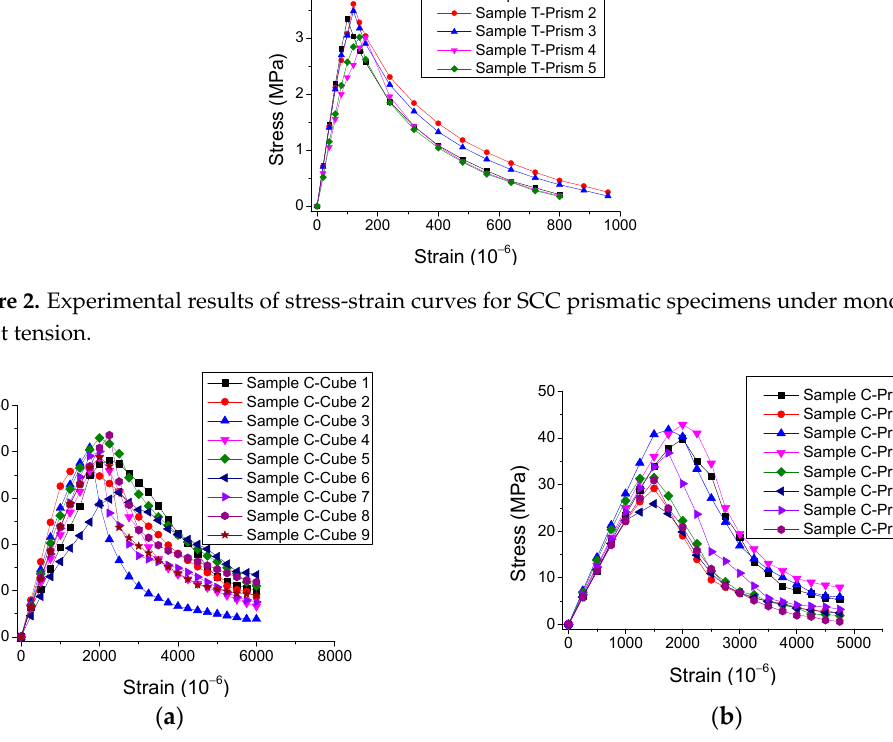
Figure 3. Experimental results of stress-strain curves for SCC under monotonic compression. ( a ) Cube specimens and ( b ) prismatic specimens.